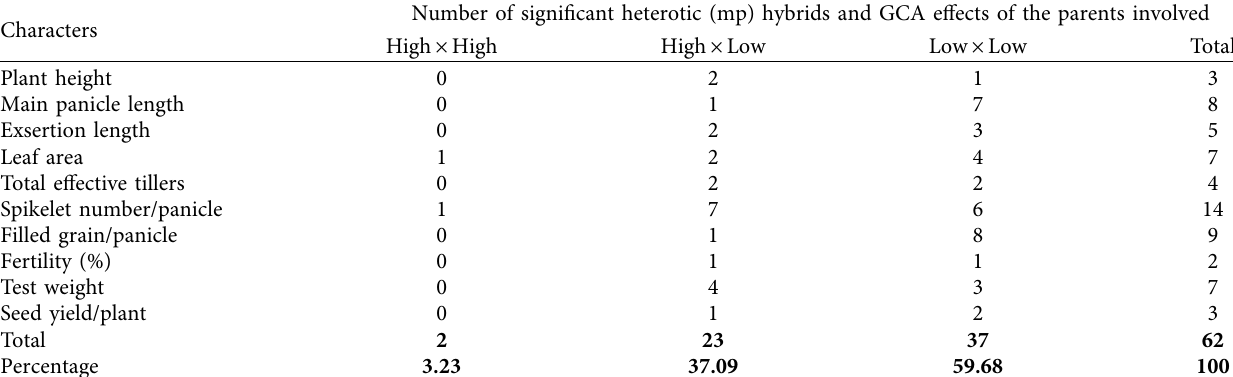
Table 9: Frequency of crosses as per GCA effect of parents for economic characters.